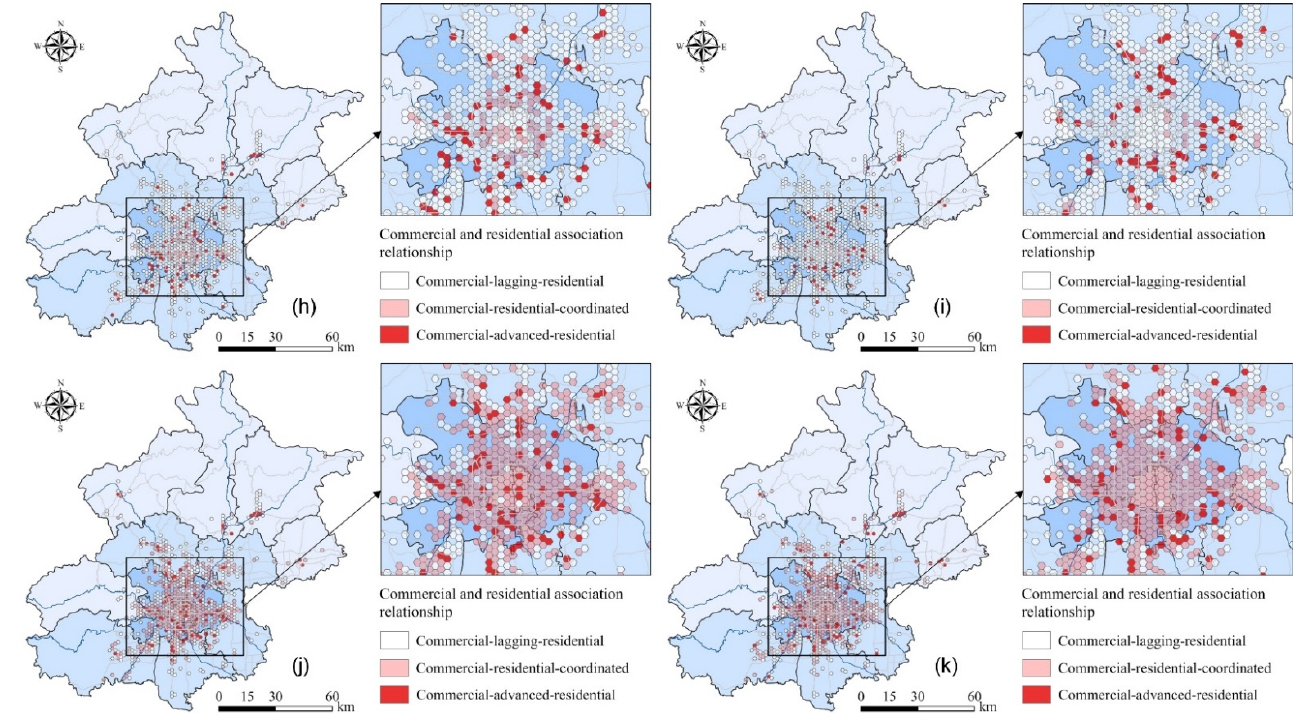
Figure 8. The distribution of association relationships between commercial and residential spaces in Beijing: ( a ) the overall commercial spaces, ( b ) catering services, ( c ) recreation and leisure services, ( d ) living services, ( e ) convenience stores, ( f ) supermarkets, ( g ) shopping malls, ( h ) home appliance and electronics stores, ( i ) home building materials markets, ( j ) specialty stores, and ( k ) agricultural markets.